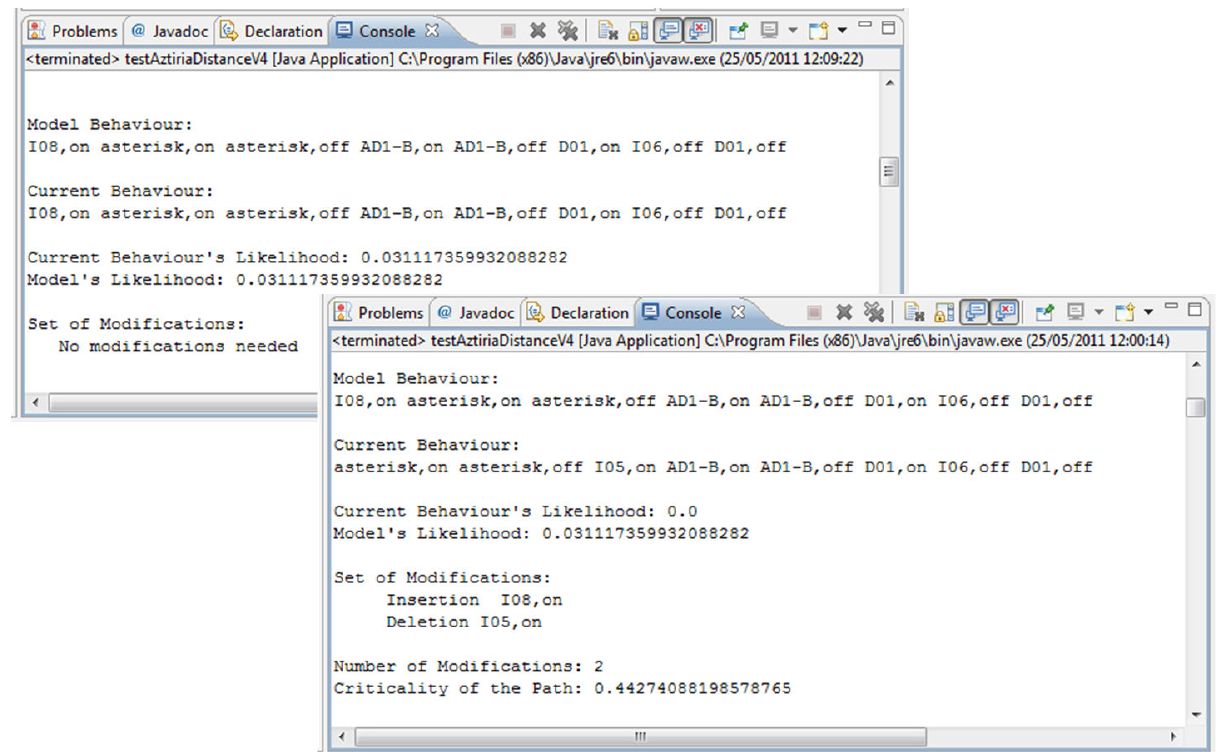
LFPUBS algorithm. Adapted cross-validation validates if the algorithm identifies shifts from frequent behaviors. As a result